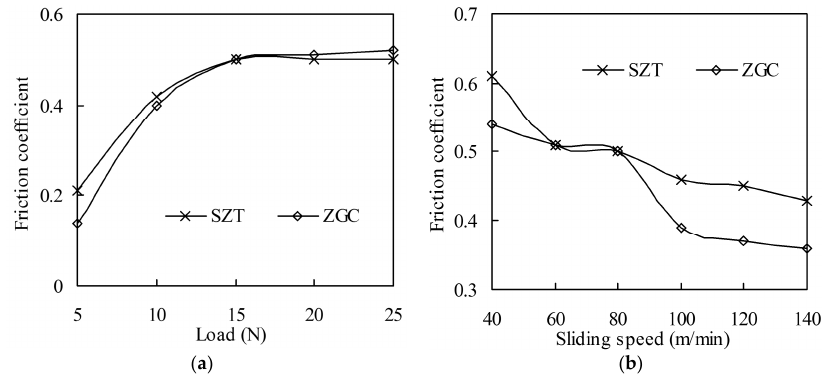
Figure 4. Friction coefficient of the coatings under different loads (speed 80 m/min) and sliding speeds (load 15 N). (Test time 5 min): ( a ) Friction coefficient under different loads; ( b ) Friction coefficient under different sliding speeds.